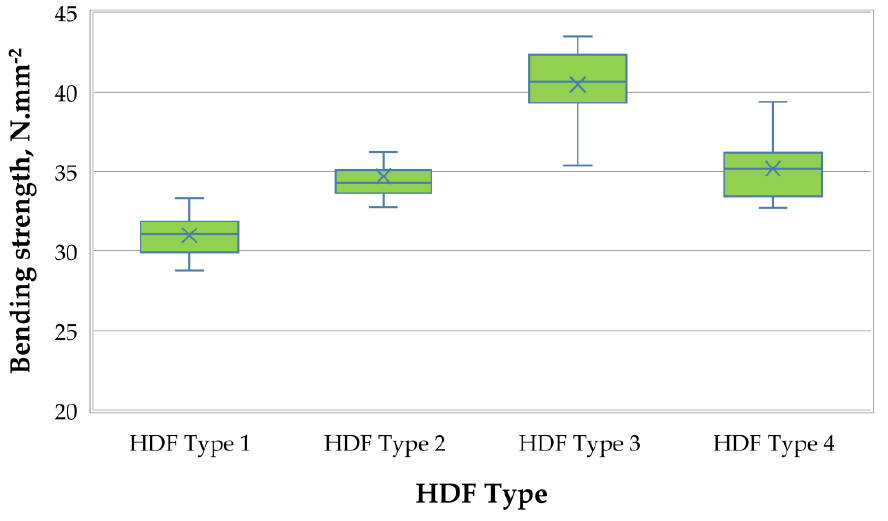
Figure 5. Bending strength (MOR) of HDF panels produced.